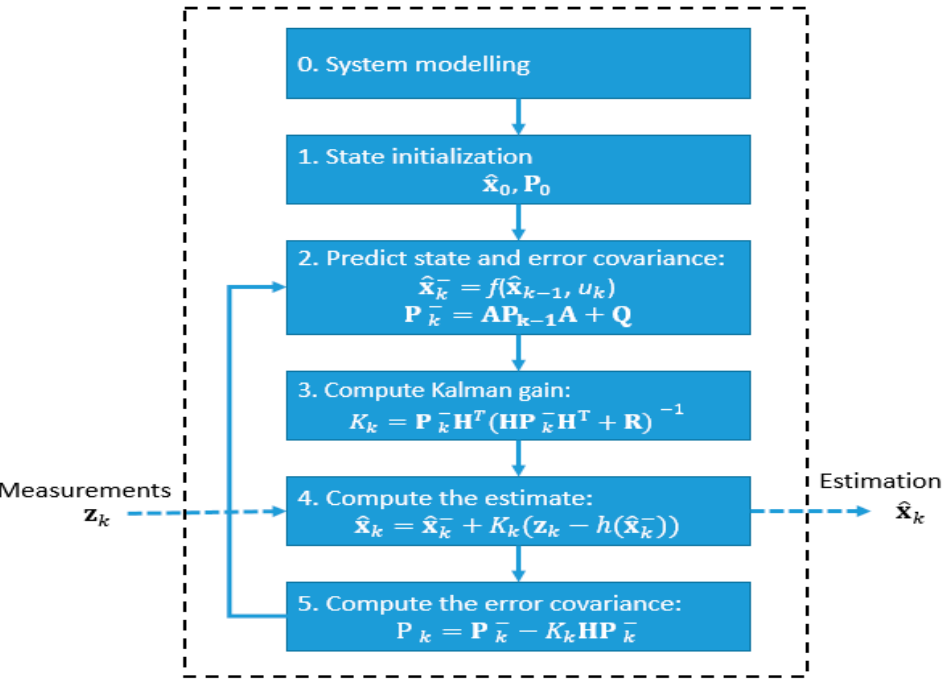
Figure 9. EKF algorithm flowchart.